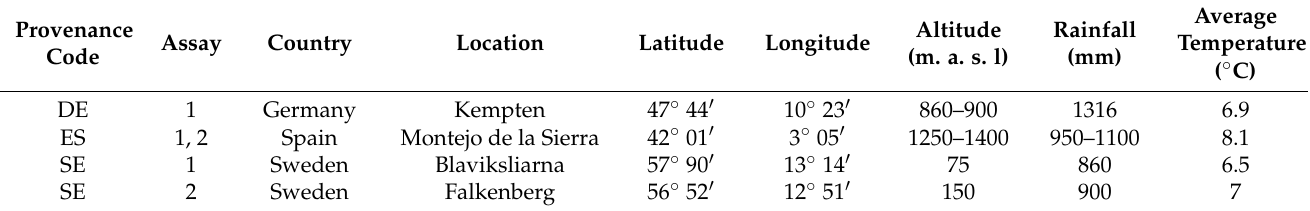
Table 1. Location and climatic details of the provenances studied in the diversity (1) and water treatment (2)